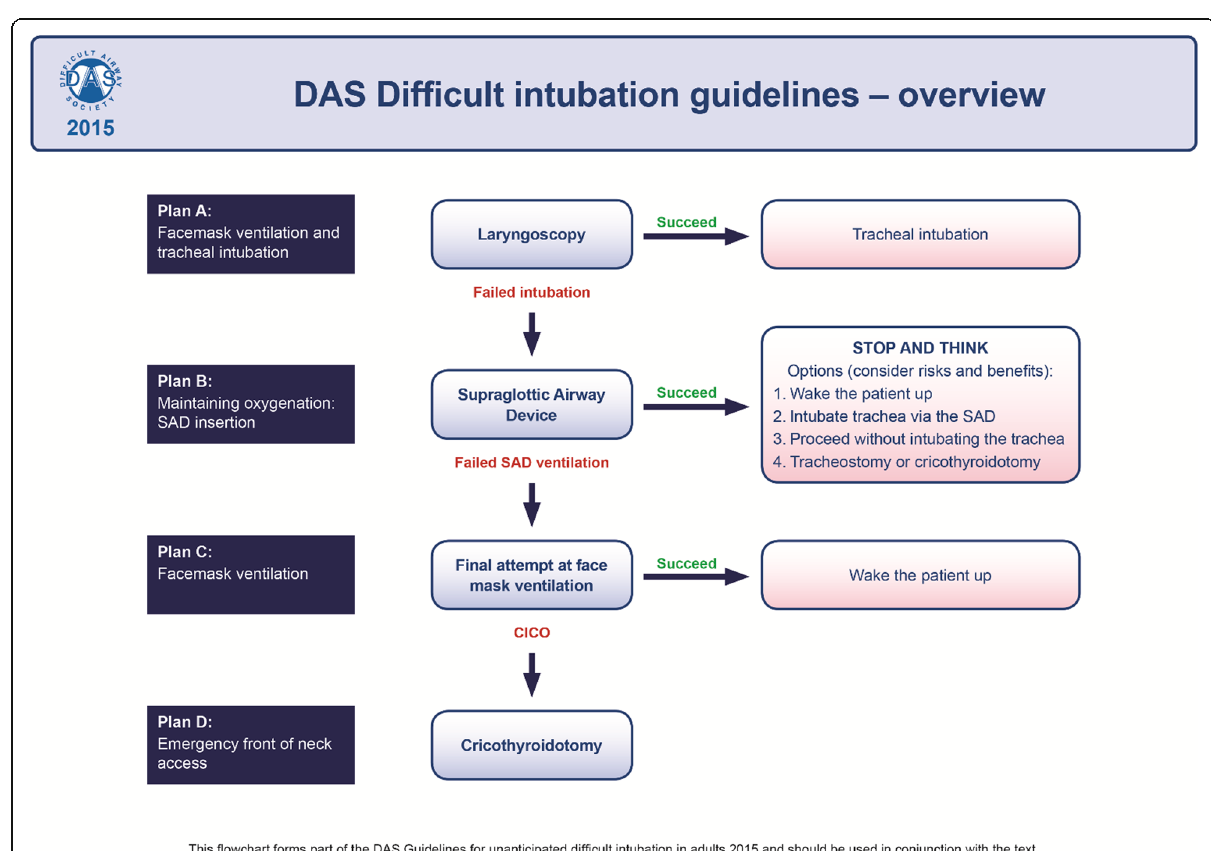
Fig. 1 DAS Guidelines : Plan C (Facemask